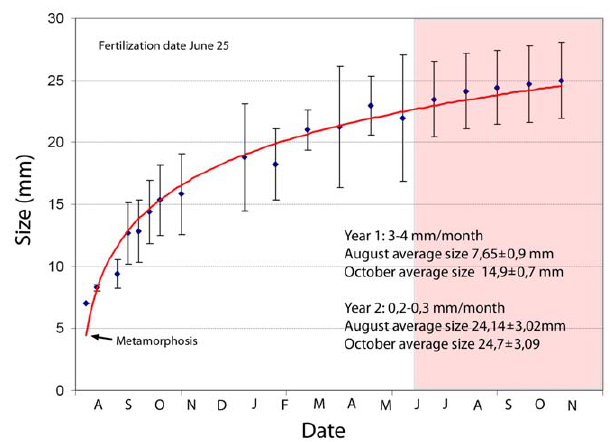
Figure 3. Growth curve of amphioxus larvae in captivity at room temperature (from 10 6 C in winter to 21 6 C in summer). The white part of the graph corresponds to the first year (animals were fertilized in late June 2007 and the graph starts when these embryos become post-metamorphic larvae in August 2007) and the pink side to the second year (2008). A minimum of 10 larvae were measured for each point (error bars=standard deviation from the mean).